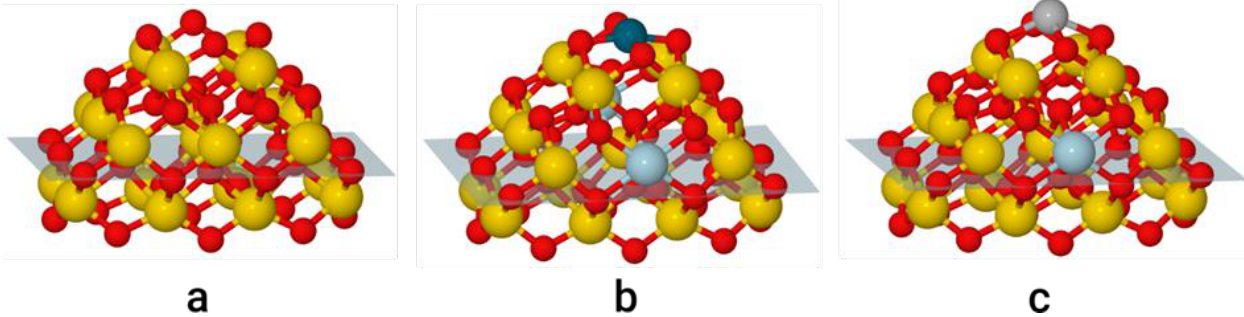
Figure 1. Models of Ce 21 O 42 NP: ( a ) without metal atom; ( b ) with Pd atom anchored at {100} facet; ( c ) with Ag atom anchored at {100} facet. The Ce 4+ , Ce 3+ , Pd, Ag, and O atoms are shown in yellow, light blue, dark cyan, grey, and red, respectively. The atoms under the transparent plane are omitted for clarity in the Figures 2–4.